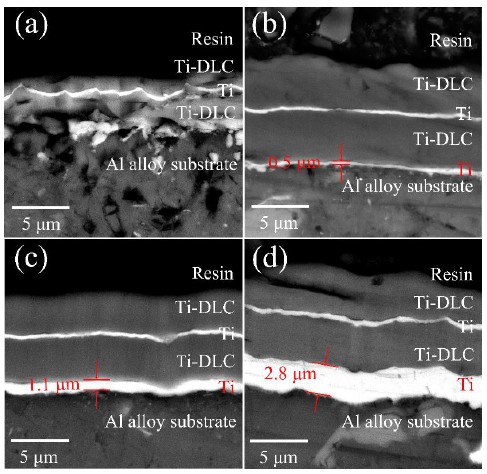
Figure 2. SEM cross-sectional image of the Ti-DLC coatings with Ti transition layer deposition time ( T ): ( a ) 0 min, ( b ) 5 min, ( c ) 10 min, and ( d ) 20 min.